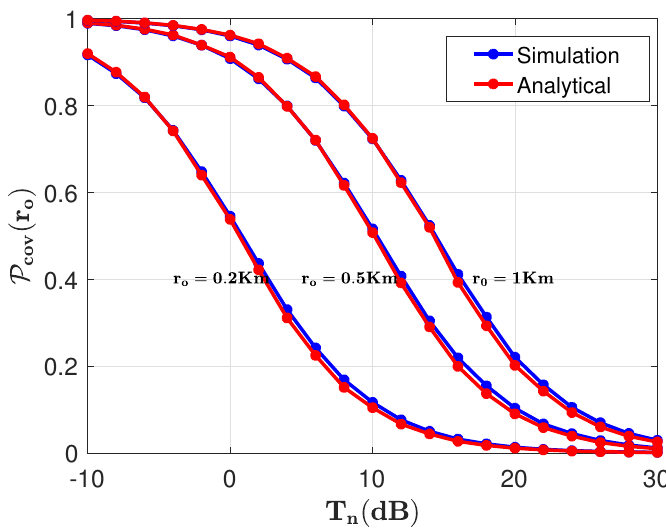
Figure 4. Probability of coverage as function of quality of service with ( κ = 2 ) .